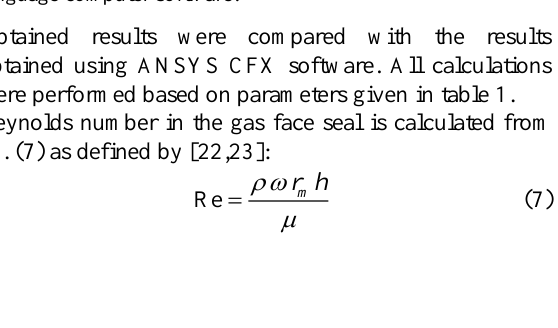
Fig. 4. Finite element mesh.